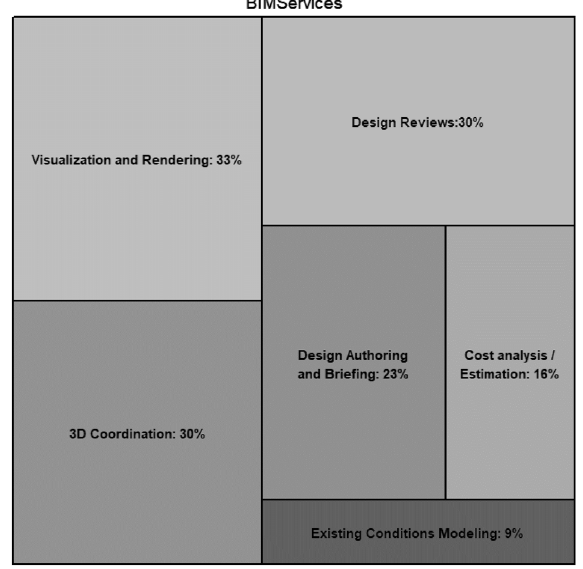
Figure 5. BIM services.